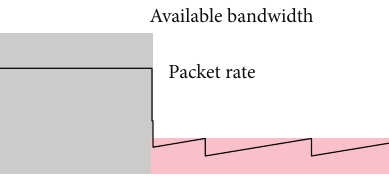
Figure 2: Elastic traffic